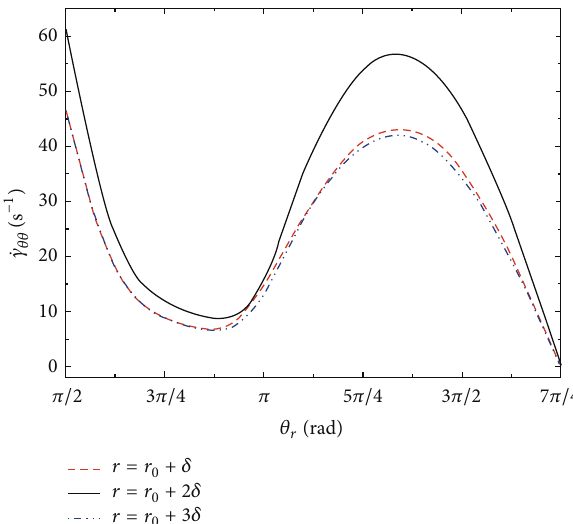
Figure 6: The circumferential tensile strain rate of melt moving in a chamber of VCPU: feed process.